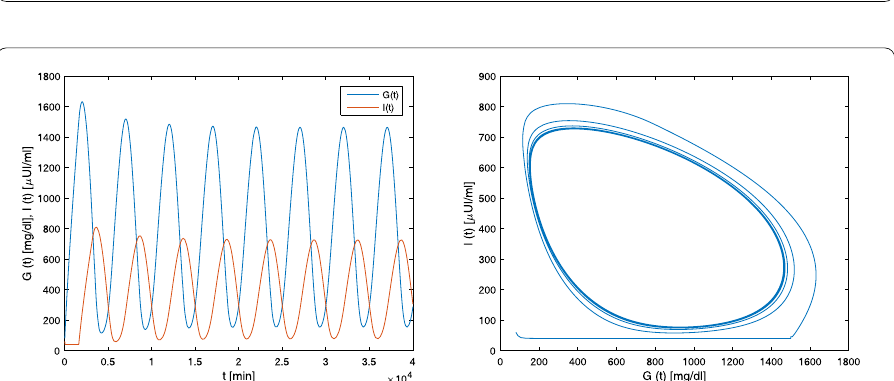
Figure 4 Time series and phase portrait of fractional-order model (29) generated using the information from Set 2, the parameter values in Eq. (58), and τ = 1600 > τ 0 = 1365.60. A periodic oscillation bifurcates from the equilibrium point ( G ∗ , I ∗ ) = (722.65,359.07)